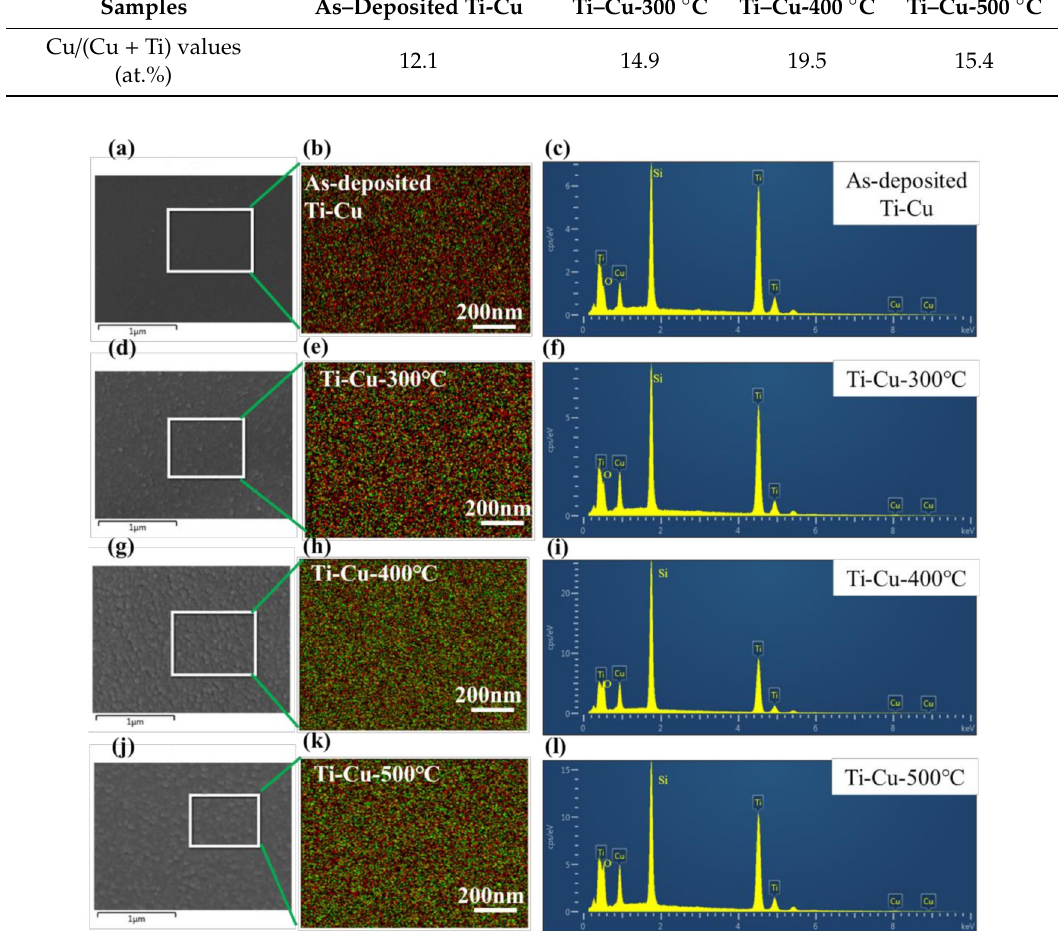
Figure 1. ( a , d , g , j ) Surface morphology evaluated by SEM, ( b , e , h , k ) the distribution of Cu and Ti elements evaluated by energy dispersive X-ray spectroscopy (EDS) mapping corresponded to SEM images, and ( c , f , i , l ) the EDS spectra corresponded to SEM images for the Ti–Cu coatings deposited on silicon substrates. The images are obtained from samples before (as-deposited) and after annealing at various temperatures of 300, 400, and 500 ◦ C (red points for Ti, and green points for Cu for the EDS